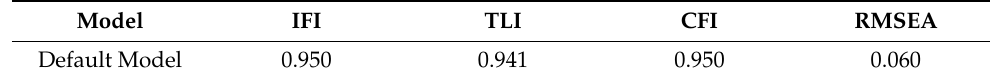
Table 5. Model fit of the measurement model.